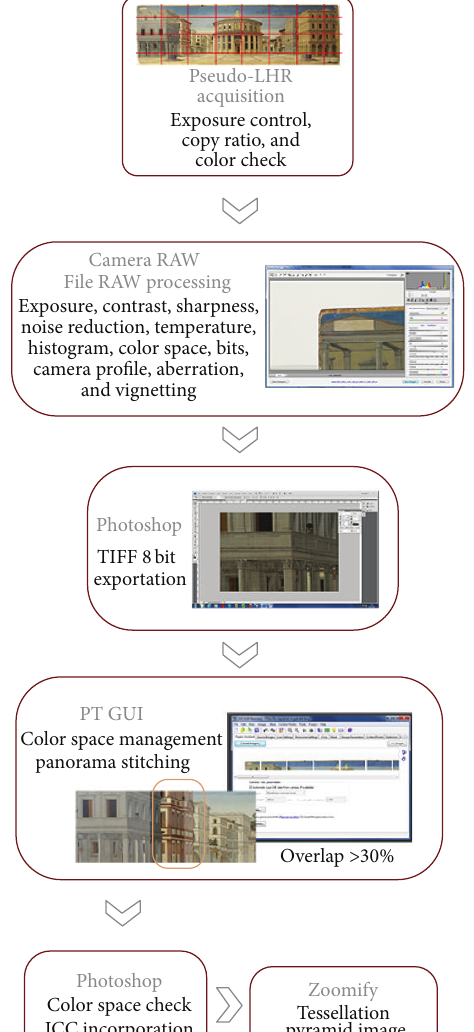
Figure 2: The workflow for the high-resolution image.